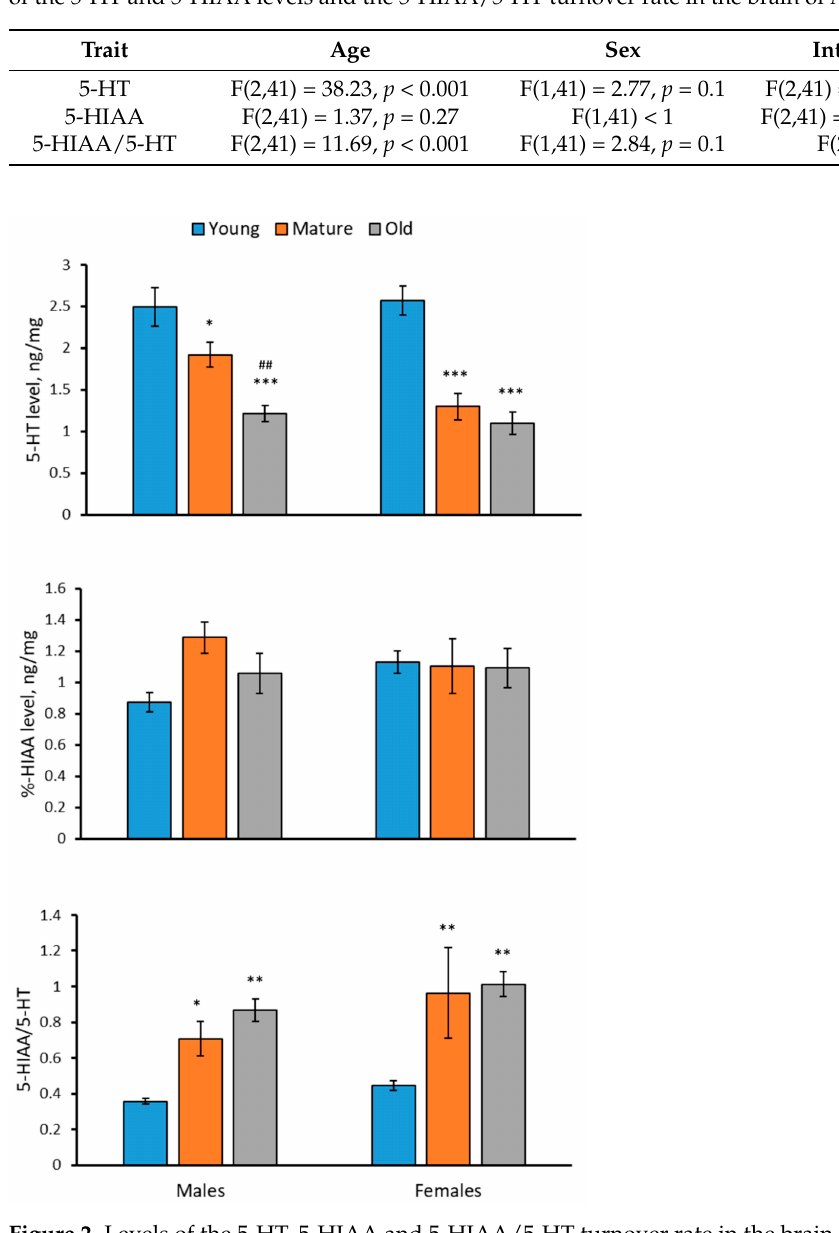
Table 1. Two-way ANOVA of the effects of “Age”, “Sex” factors and their interaction on the variability of the 5-HT and 5-HIAA levels and the 5-HIAA/5-HT turnover rate in the brain of N. furzeri .